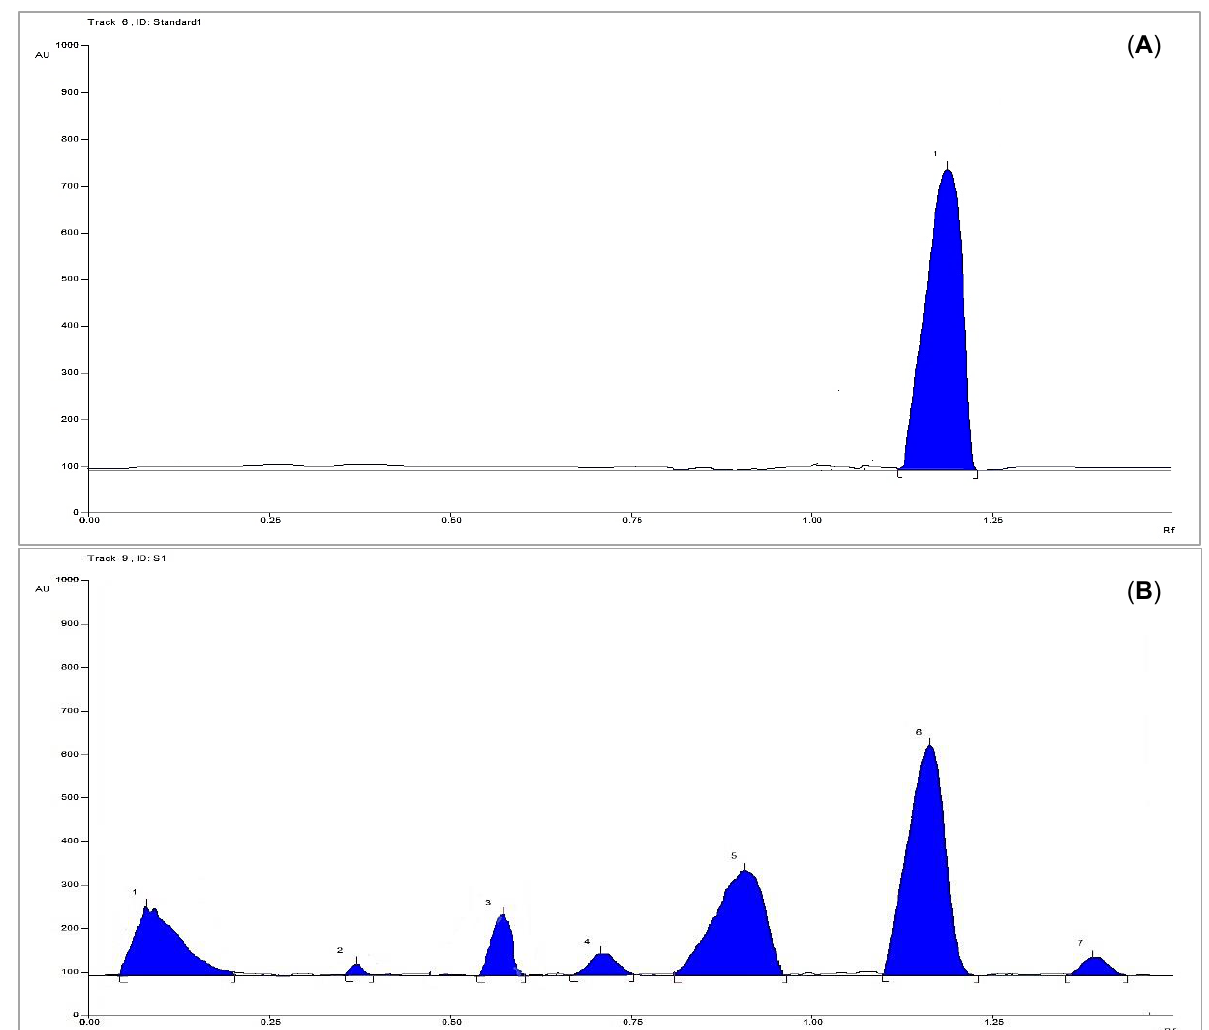
Figure 3. ( A ) HPTLC chromatogram of 6 µ g per band of standard methyl gallate scanned at λ = 254 nm, ( B ) HPTLC chromatogram of 300 µ g per band of the plant extract scanned at λ = 254